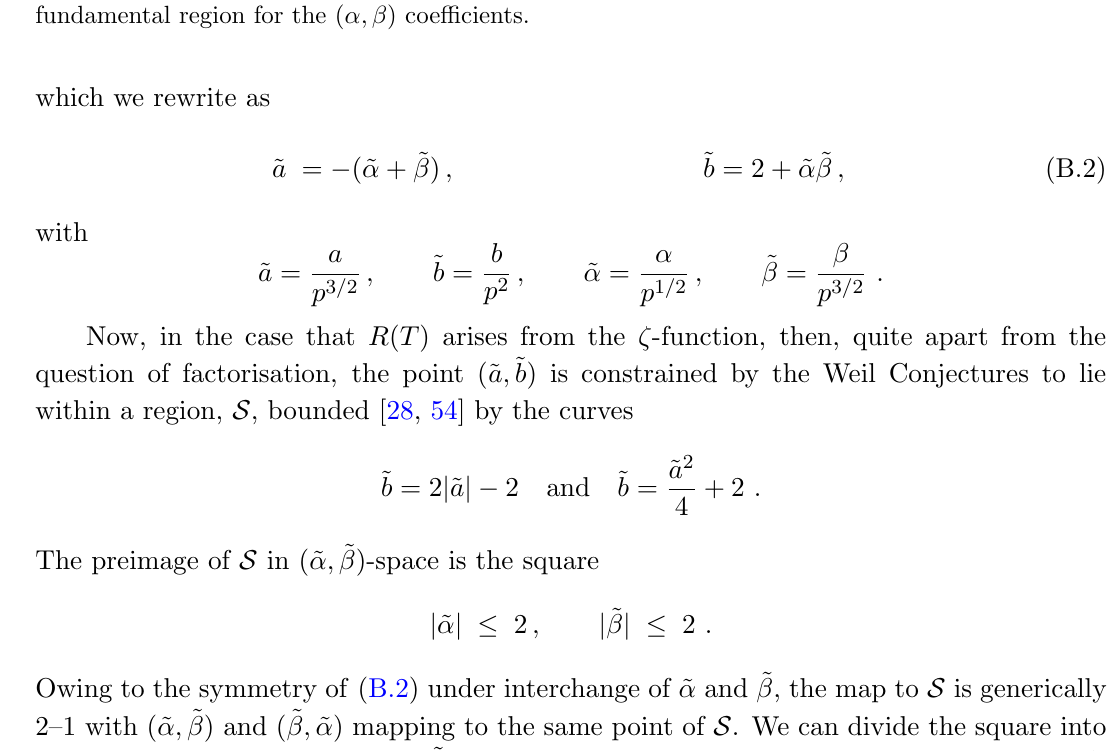
Figure 19 . The allowed regions for the ( a; b ) and ( (cid:11); (cid:12) ) coe(cid:14)cients. The region on the left maps 2{1 onto the region on the right. Either of the two triangular regions shown can be taken to be a fundamental region for the ( (cid:11); (cid:12) )